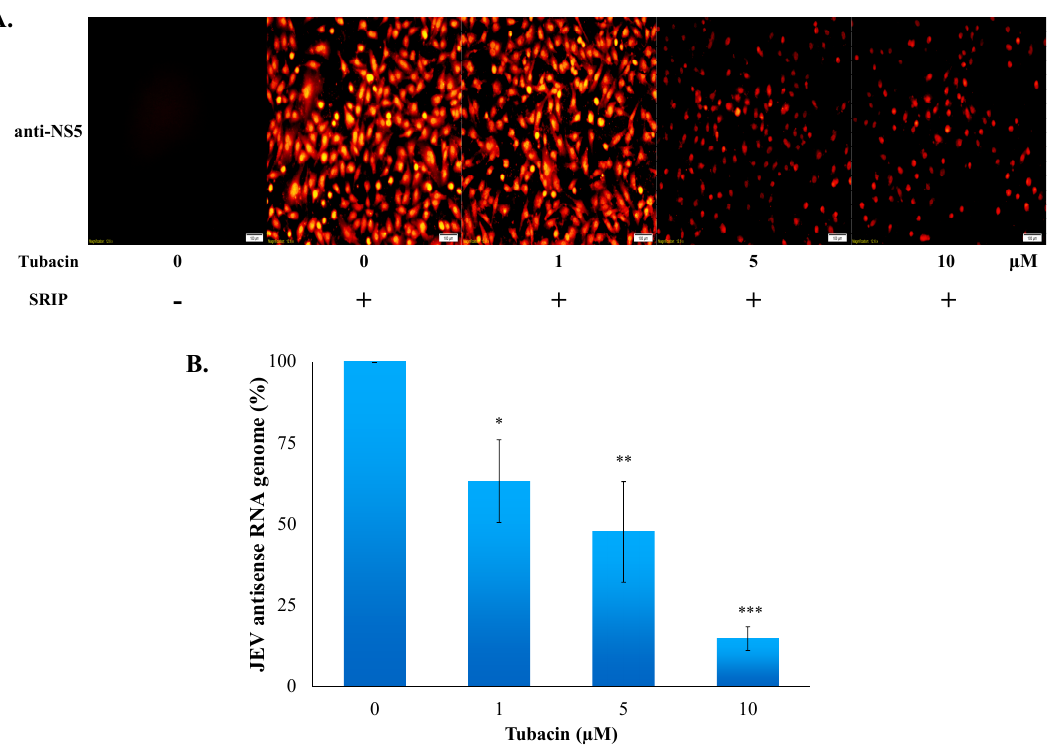
Figure 7. Inhibitory effect of tubacin on the expression of NS5 protein and viral antisense RNA genome in a JEV infected cell. For exploring the NS5 level, infected cells treated with or without tubacin were washed and fixed 36 h post infection, then followed by immunofluorescent staining with anti-NS5 antibodies and Alexa Fluor 546-conjugated secondary antibodies ( A ); For quantitating antisense RNA genomes, total RNAs from the infected cells in the presence and absence of tubacin were performed using real time RT-PCR assay ( B ). * p value < 0.05; ** p value < 0.01; *** p value < 0.001 compared with untreated infected cells. Scale bar = 100 μ m.